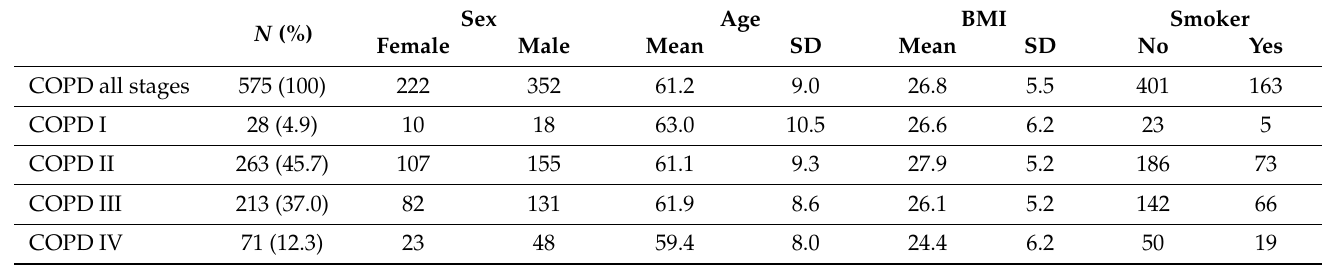
Table 1. Anthropometric data, smoking behavior, and COPD GOLD classification of included